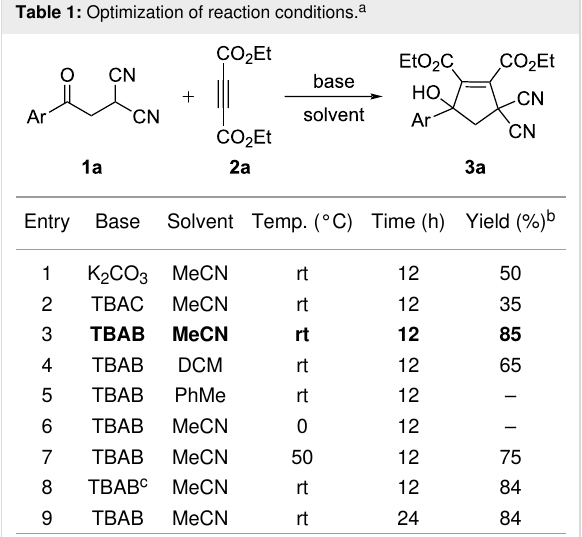
Table 1: Optimization of reaction conditions. a